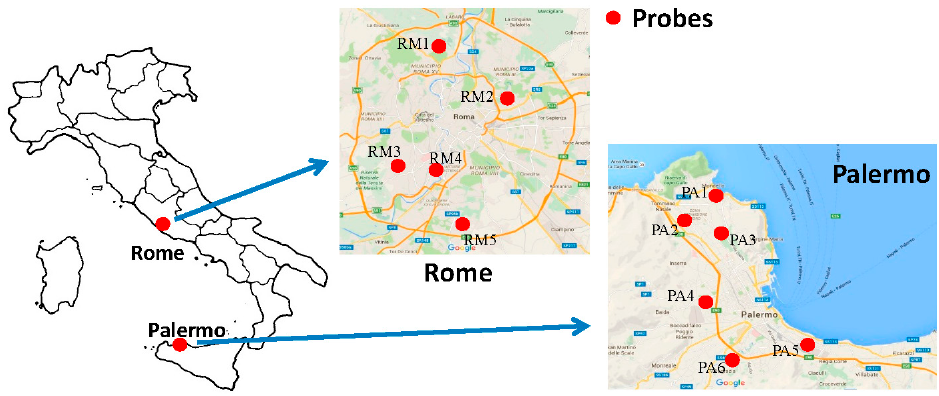
Figure 12. Geographical distribution of the probes in Italy: five in Rome and six in Palermo.